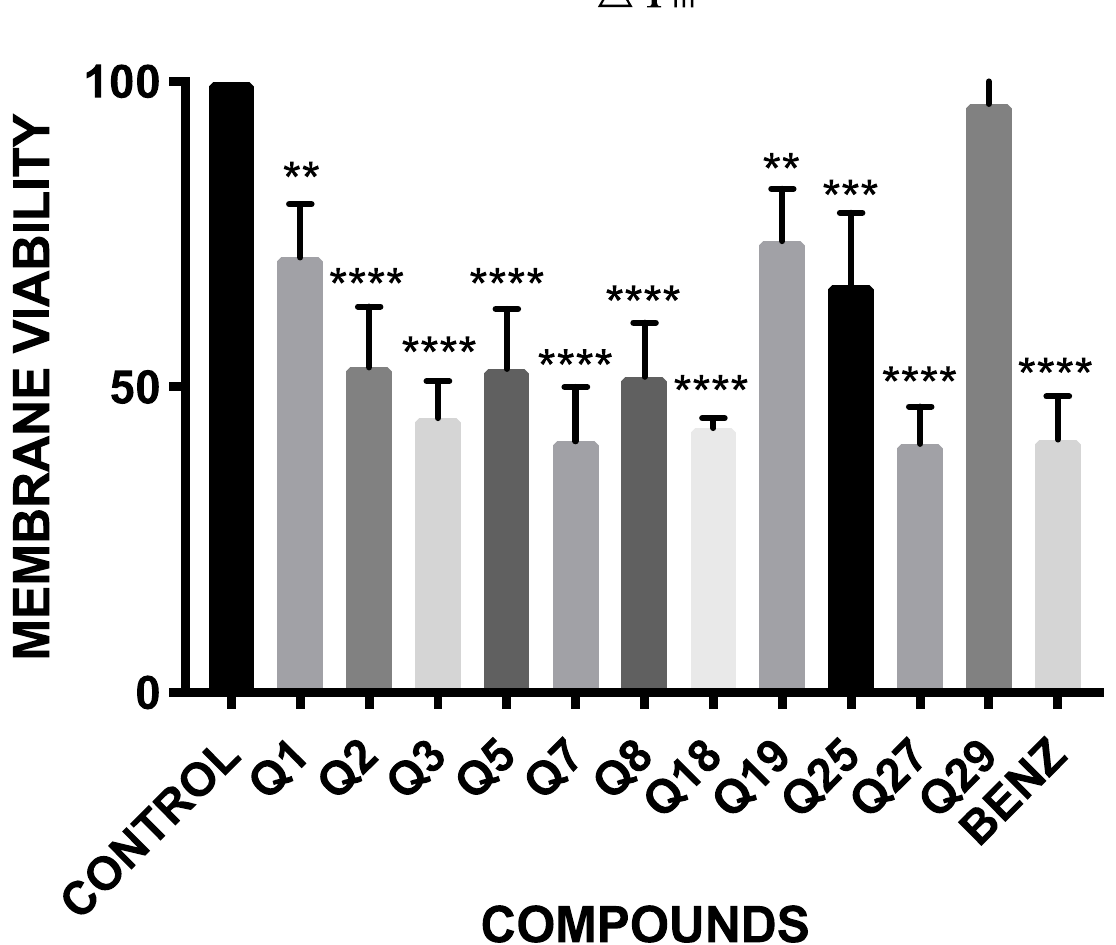
Figure 2. Percentage relative to control of mitochondrial membrane potential variations ( ∆Ψ m). Benz: benznidazole. A Tukey test with the GraphPad.PRISM ® 7.0a soft-ware was carried out to test the statistical differences between means. ( p < 0.05 [**]; p < 0.001 [***]; p < 0.0001 [****]).